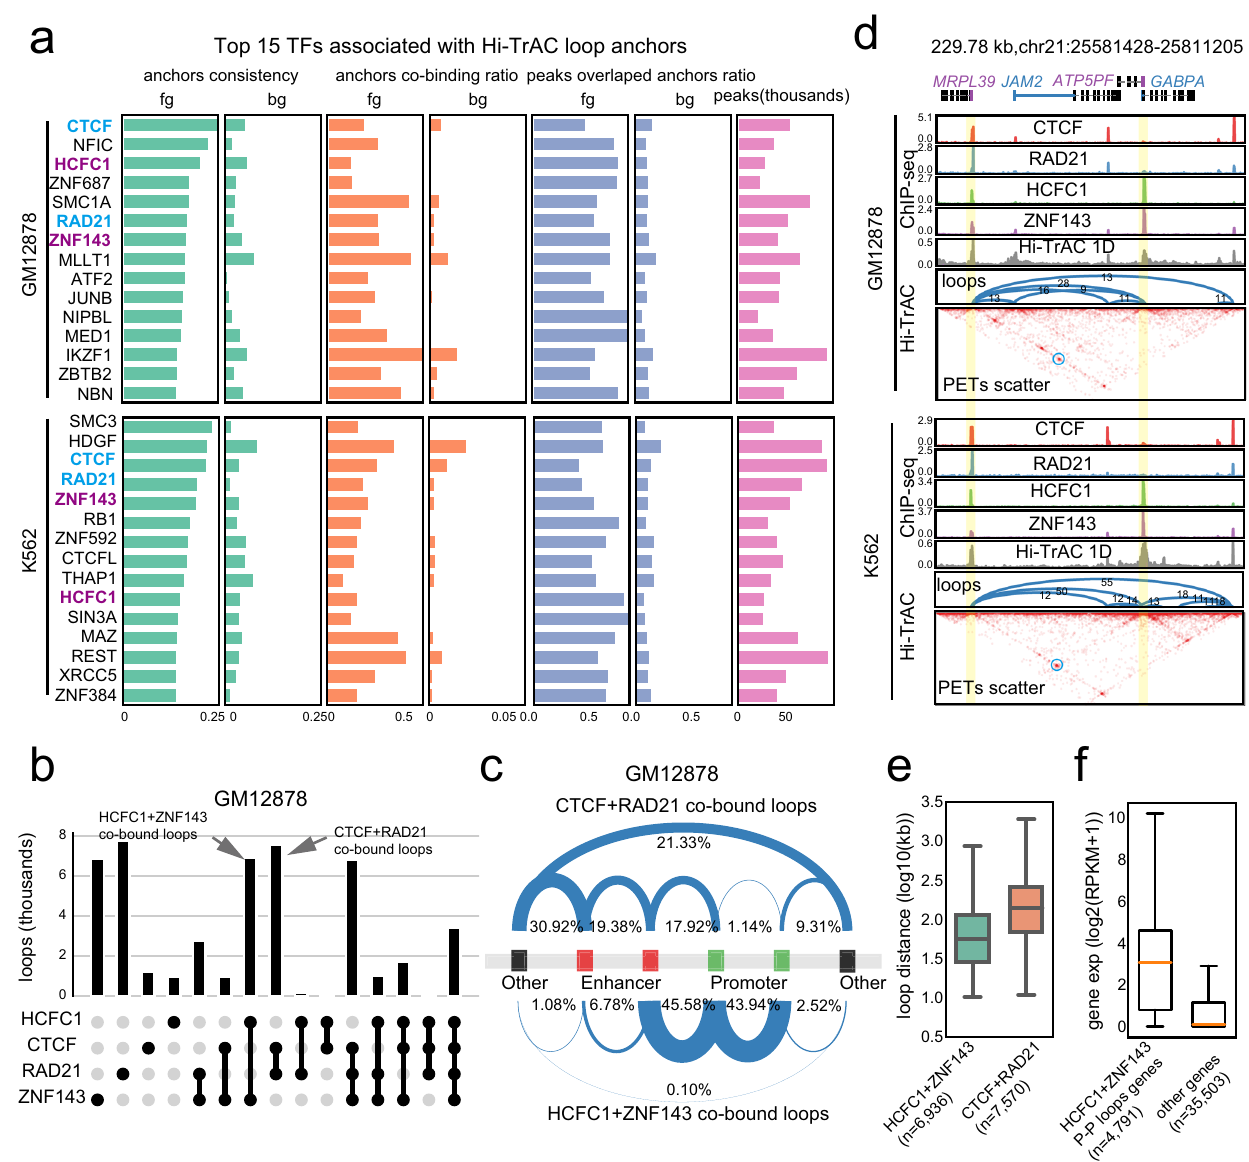
Fig. 3 | Division of labor in regulating different categories of chromatin loops by distinct transcription factors. a The top 15 transcription factors associated with the Hi-TrACloop anchorsin GM12878 and K562 cells. The binding sites of 162 and360transcriptionfactorswerecompiledfromtheReMap2020 105 forGM12878 and K562, respectively. The top 15 factors most signi fi cantly associated with loop anchors, sorted by consistency, are shown as indicated on the left of the panel (Supplementary Data 5 ) . Overlapped top factors between GM12878 and K562 are highlighted in purple and blue. Fg stands for foreground data, which means the actual loops. Bg stands for background data, which means regions nearby actual loop anchors and used as controls. Source data are provided as a Source Data fi le. b Thedistributionofloops(toppanel)boundbyHCFC1,CTCF,RAD21,andZNF143 alone or in combination (bottom panel) at both anchors in GM12878. Source data are provided as a Source Data fi le. c Summary of loop categories with regard to putative cis-regulatory elements for loops co-bound by HCFC1 plus ZNF143 and